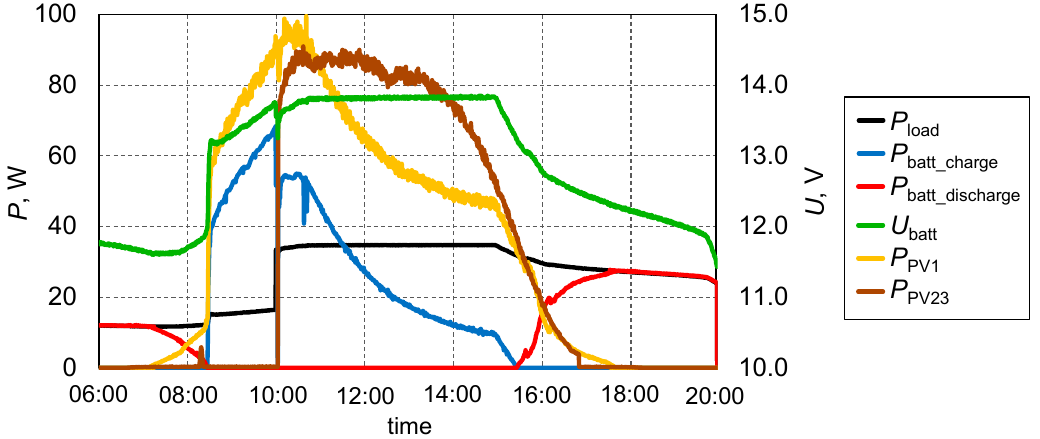
Figure 12. Power flows in the PV-battery setup.